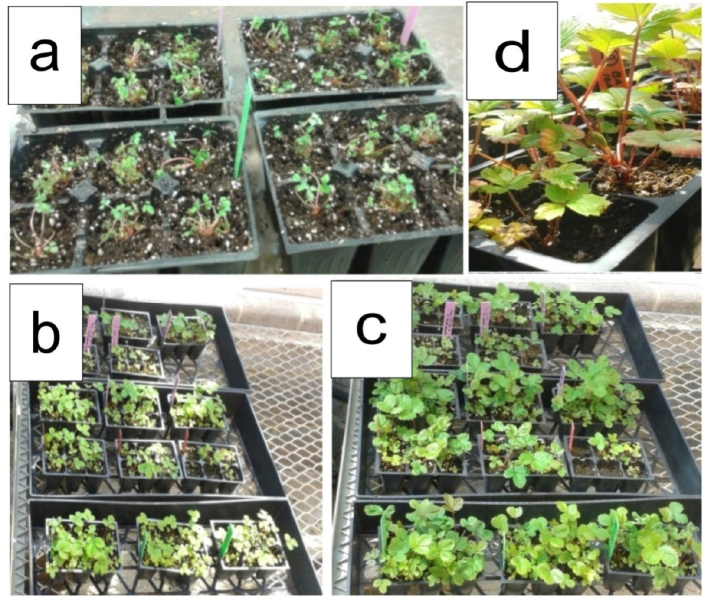
Figure 3. ( a ) Rooted plantlets placed in ProMix BX in a plastic pot in a mist chamber; ( b ) rooted plantlets in the greenhouse after 2 weeks in the mist chamber; ( c ) plants after being acclimatized